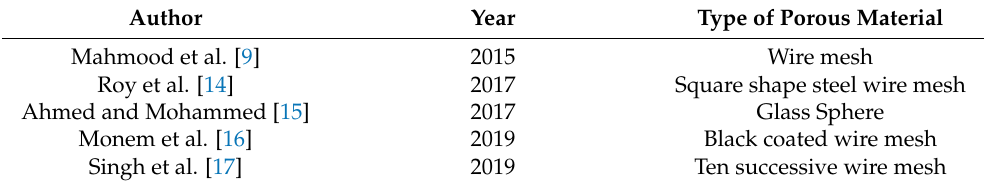
Table 1. Summary of different types of porous materials as the packed bed.